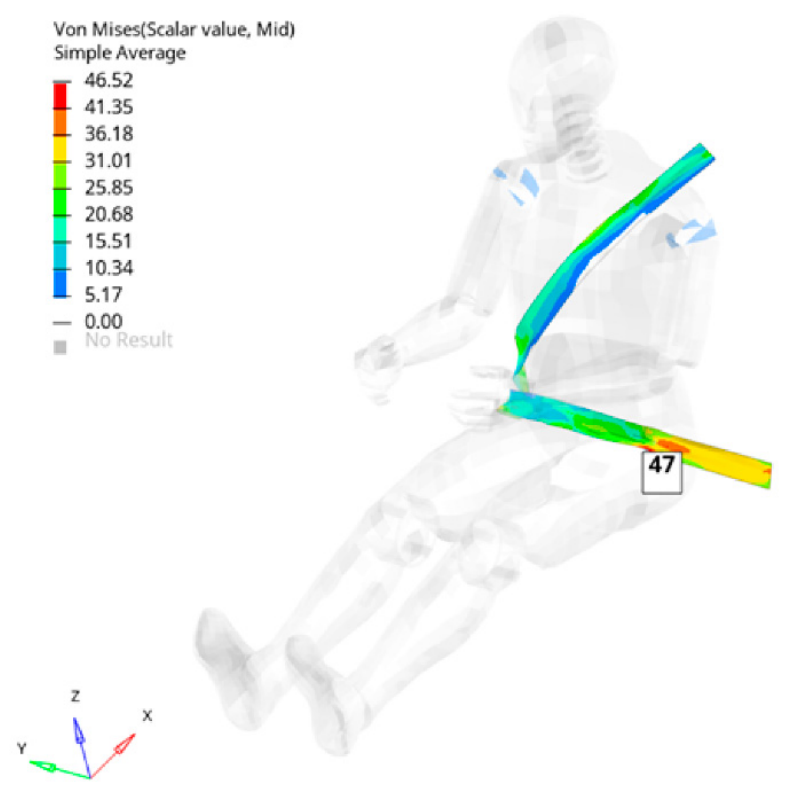
Figure 11. Stress in the belt when T = 0.020 s (in MPa).